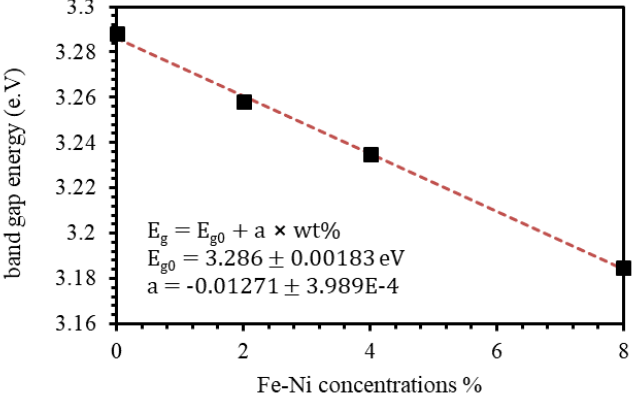
Figure 10. E g of undoped ZnO and Fe-Ni co-doped ZnO of thin films as a function of Fe-Ni co-doping levels.